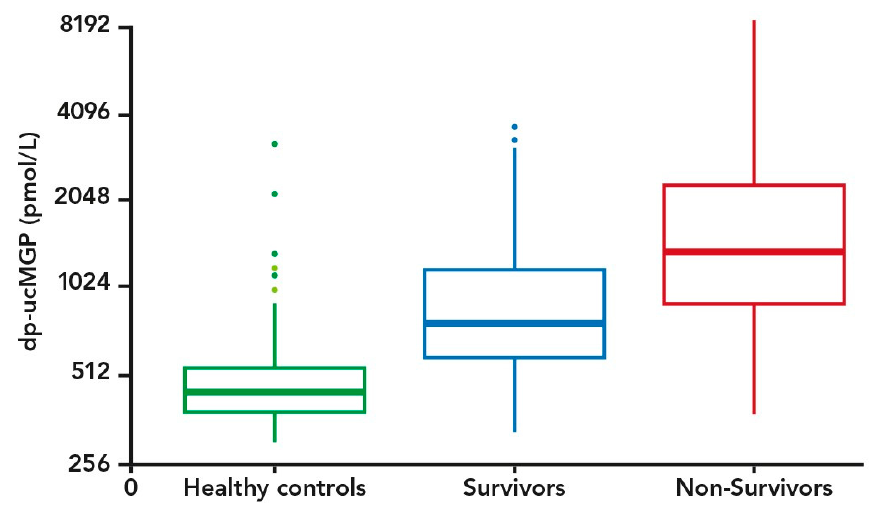
Figure 1. Boxplot of dp-ucMGP levels (pmol/L) among controls ( n = 138) and COVID-19 patients